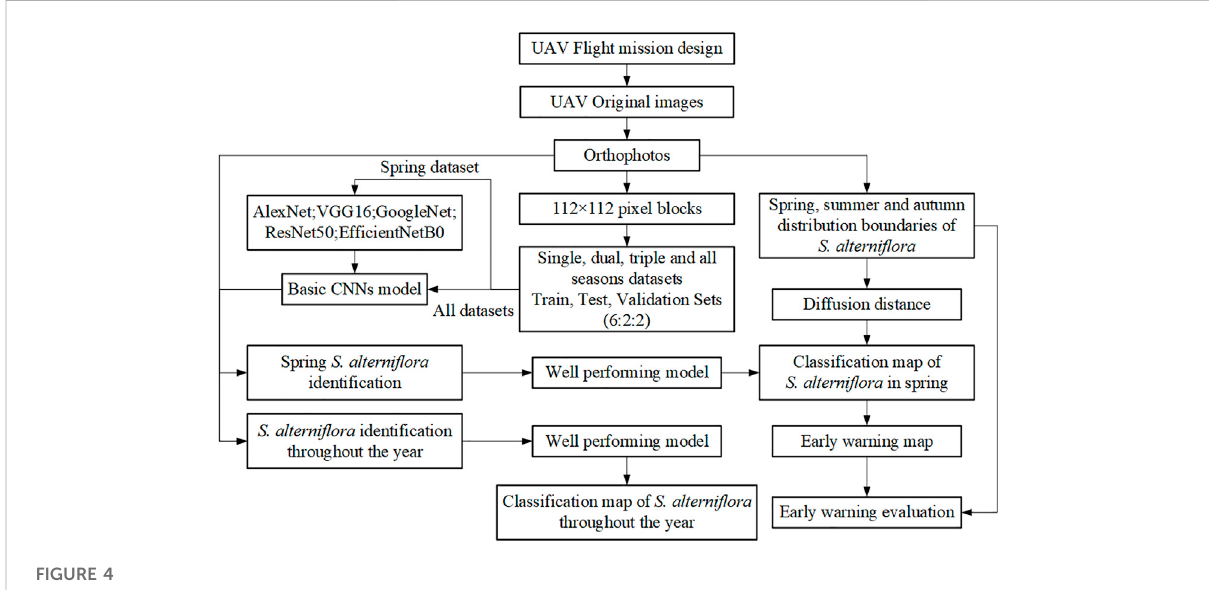
FIGURE 4 Research technical